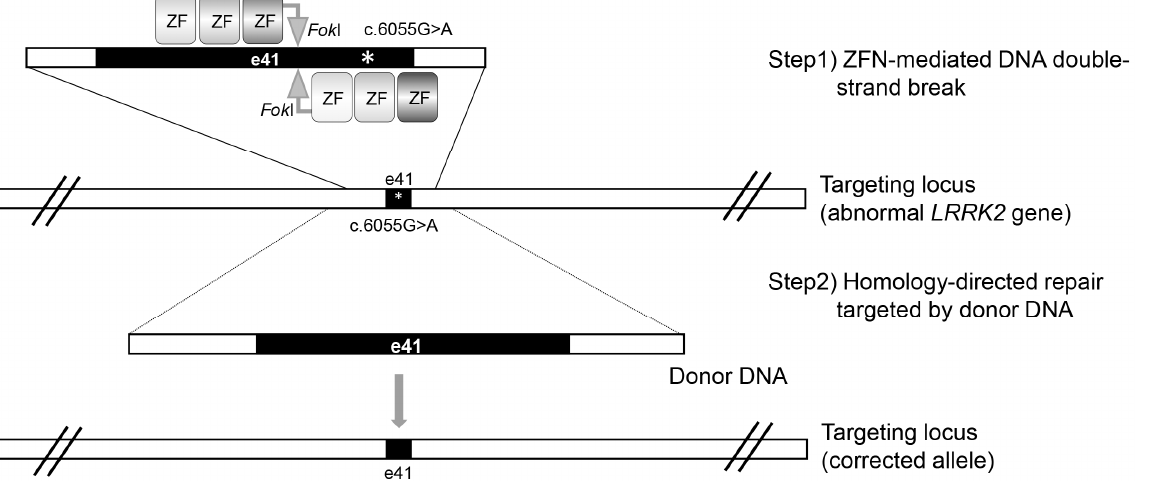
Figure 1. ZFN ‐ mediated LRRK2 gene correction. Following the induction of the ZFN ‐ mediated DNA double ‐ strand break adjacent to the LRRK2 G2019S gene mutation, the homology ‐ directed repair was targeted by donor DNA. The “e41” means exon 41 of LRRK2 gene. The asterisks indicate LRRK2 c.6055G>A.